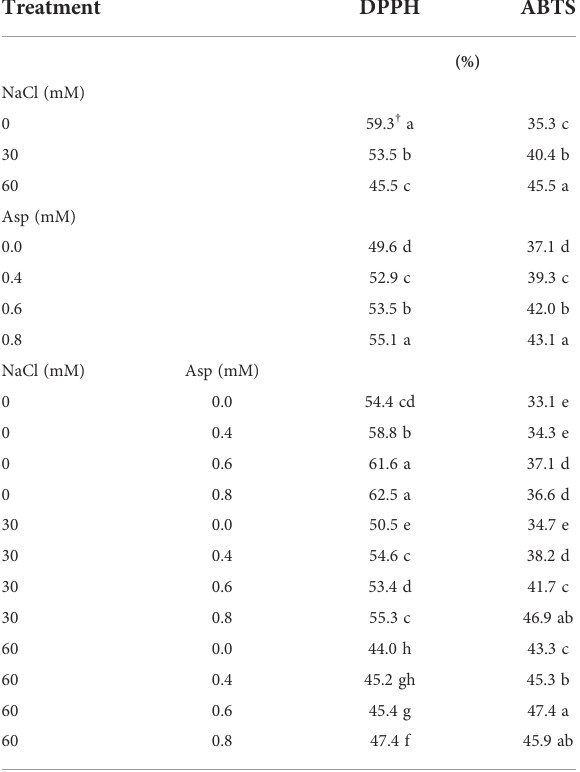
† Mean values within the same column for each trait with the same lower-case letter are not signi fi cantly different according to Tukey ’ s honestly signi fi cant difference (HSD) test at p ≤ 0.05. Measurements were done after 75 days after